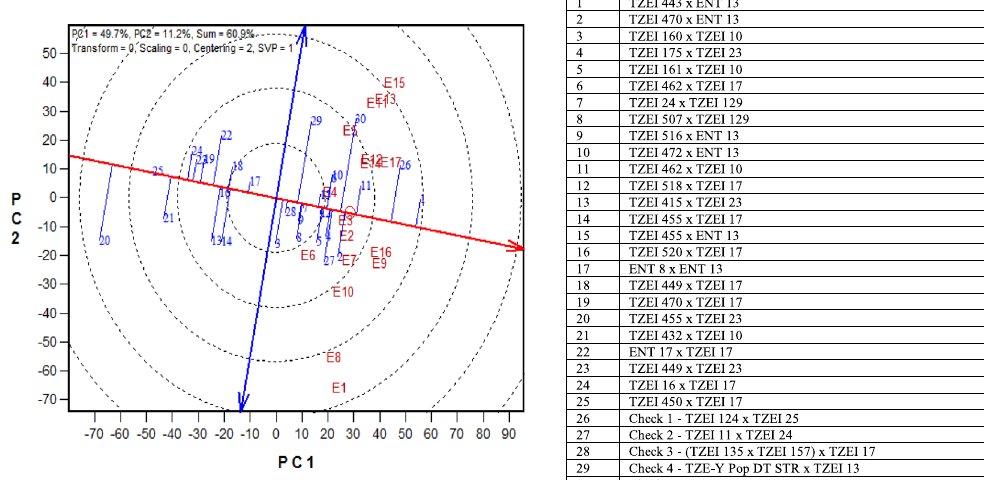
Figure 1. An entry/tester genotype main effect plus genotype x environment biplot of grain yield of 25 selected early maturing hybrids evaluated across drought, low N, Striga -infested and optimal environments in 2015 and 2016. E1 = Minjibir under drought and heat stress, 2014/2015; E2 = Ikenne under drought, 2015/2016; E3 = Kadawa under drought, 2016; E4 = Mokwa under low N, 2015; E5 = Ile-Ife under low N, 2015; E6 = Mokwa under low N, 2016; E7 = Mokwa under Striga -infested, 2015; E8 = Abuja under Striga -infested, 2015; E9 = Abuja under Striga -infested, 2016; E10 = Mokwa under Striga -infested, 2016; E11 = Mokwa under optimal, 2015; E12 = Mokwa under optimal, 2016; E13 = Ikenne under optimal, 2015; E14 = Ikenne under optimal, 2016; E15 = Abuja under optimal, 2015; E16 = Abuja under optimal, 2016; E17 = Ile-Ife under optimal,